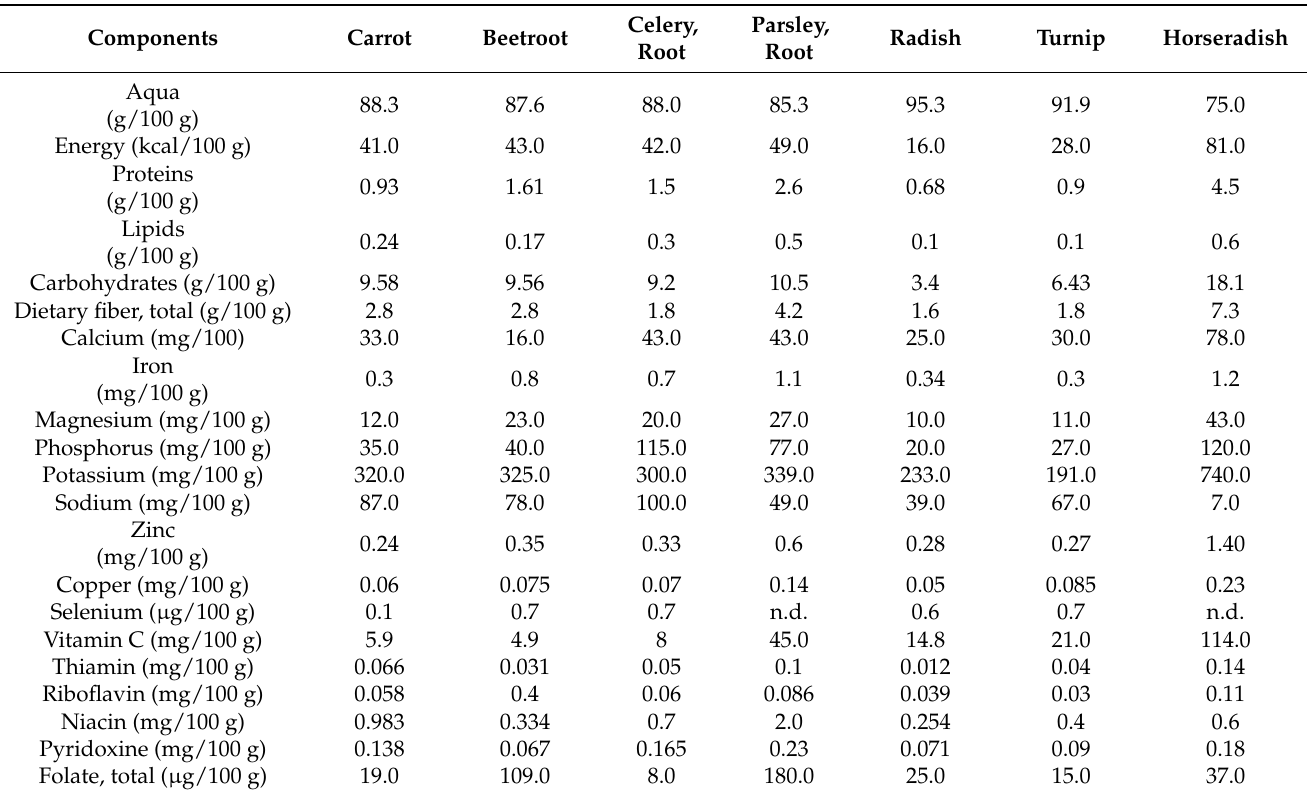
Table 1. Composition of root vegetables